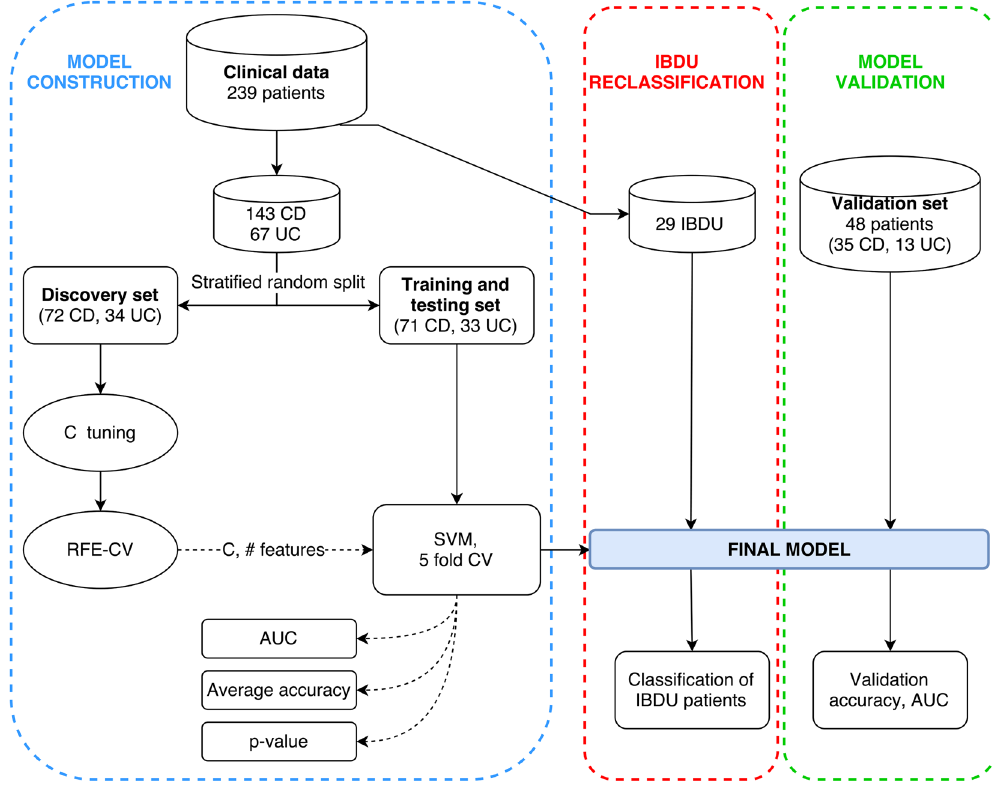
Figure 1. Model and data processing. Schematic representation of the model construction (blue section), validation (green section) and IBDU reclassification (red section) phases. Solid arrows represent data stream while dashed arrows represent parameters or metrics stream. The discovery set was used to identify the optimal penalty parameter (C) and number of features using the recursive feature elimination with cross validation algorithm (RFE-CV). These two elements were then passed to the training and testing set which was then modelled using a support vector machine (SVM). Three metrics were collected: area under the ROC curve (AUC); accuracy over the 5 folds and; a permutation-generated